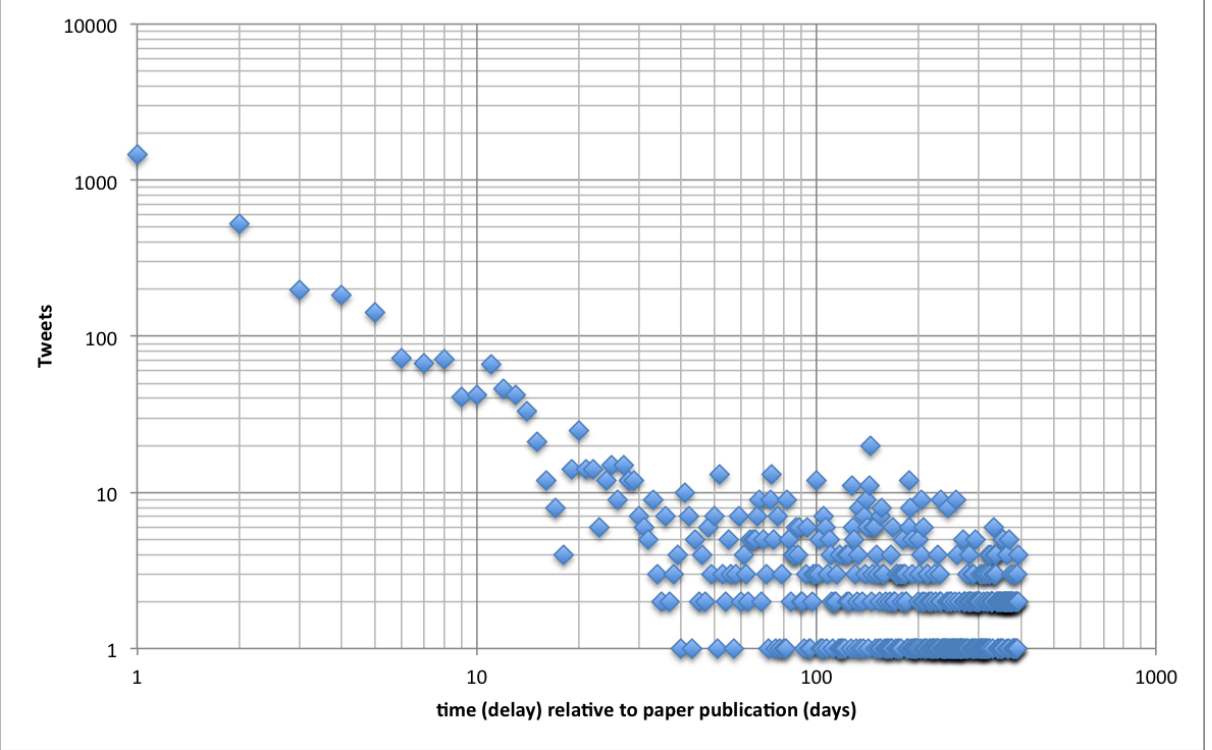
Figure 4. Tweetation dynamics over time on a log-log scale. All tweetations were categorized according to when, in relationship to the cited article publication date, they were tweeted (x-axis), with 1 being the day of article publication.